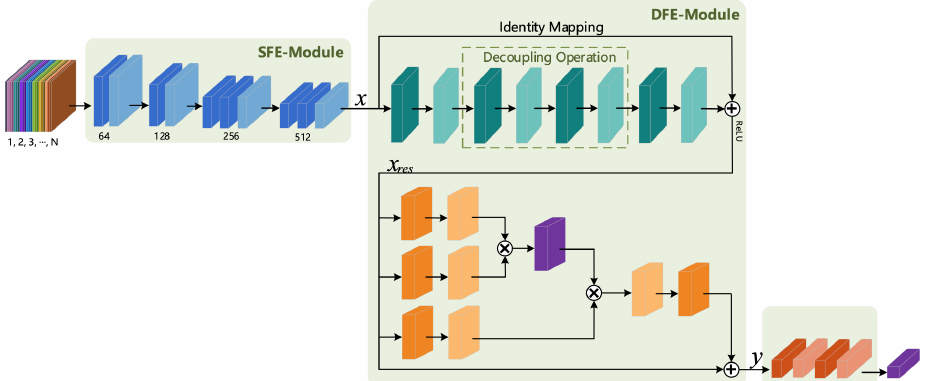
Figure 9. The architecture of